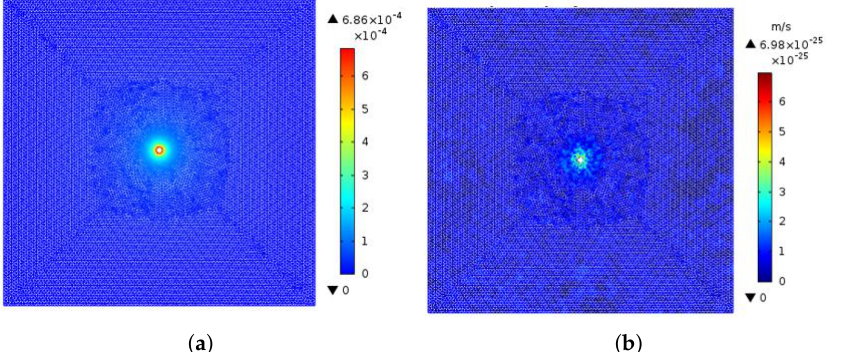
Figure 15. Two-dimensional steady-state chemo-thermo-poroelasticity simulation with COMSOL. ( a ) Rock displacement and ( b ) pore-fluid velocity.